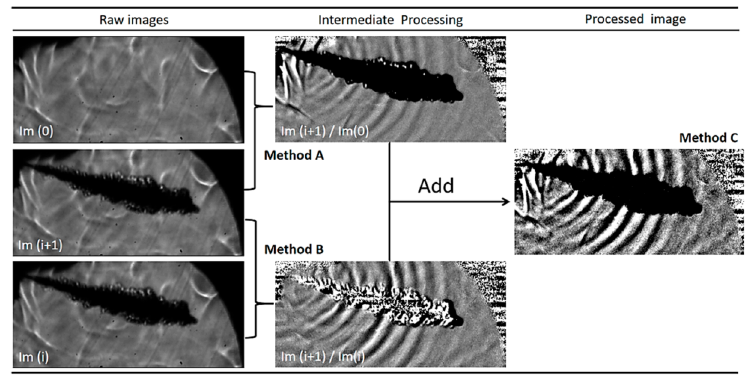
Figure 4. Images processing method. From the left, the raw spray images of Im ( 0 ), Im ( i ), and Im ( i + 1 ), the intermediate-processing images, and the processed image are shown. The raw images were obtained under an ambient-gas temperature of 500 K and a density of 6.3 kg / m 3 .